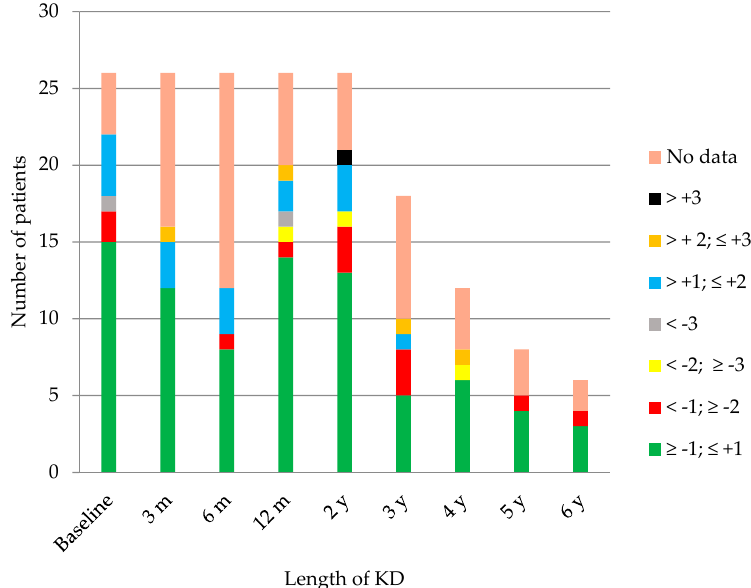
Figure 2. Number of patients in each range of the body mass index (BMI) z-score throughout time. KD: ketogenic diet, m: months, y: years.